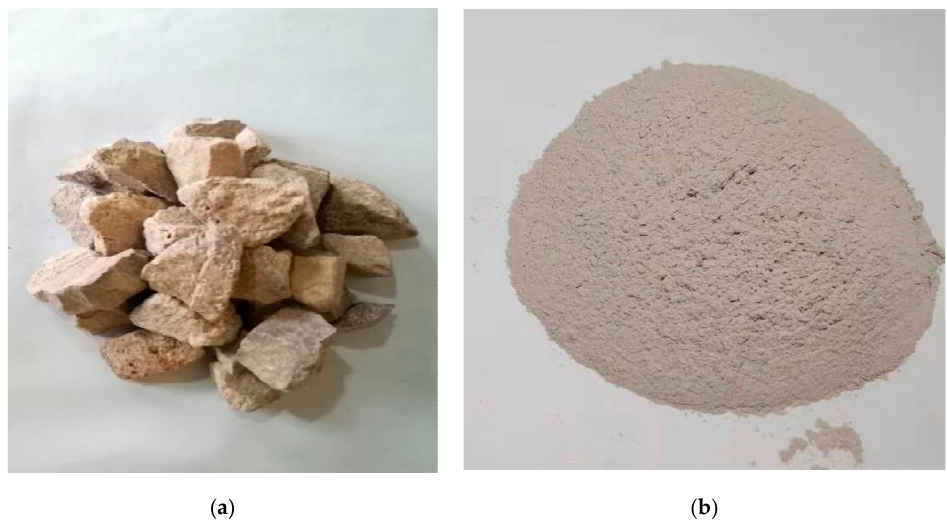
Figure 1. Optical photographs of coarse aggregate ( a ) and large bibulous stone powder (LBSP) ( b ). Table 1. Chemical composition of large bibulous stone powder. Chemical Composition (wt%)